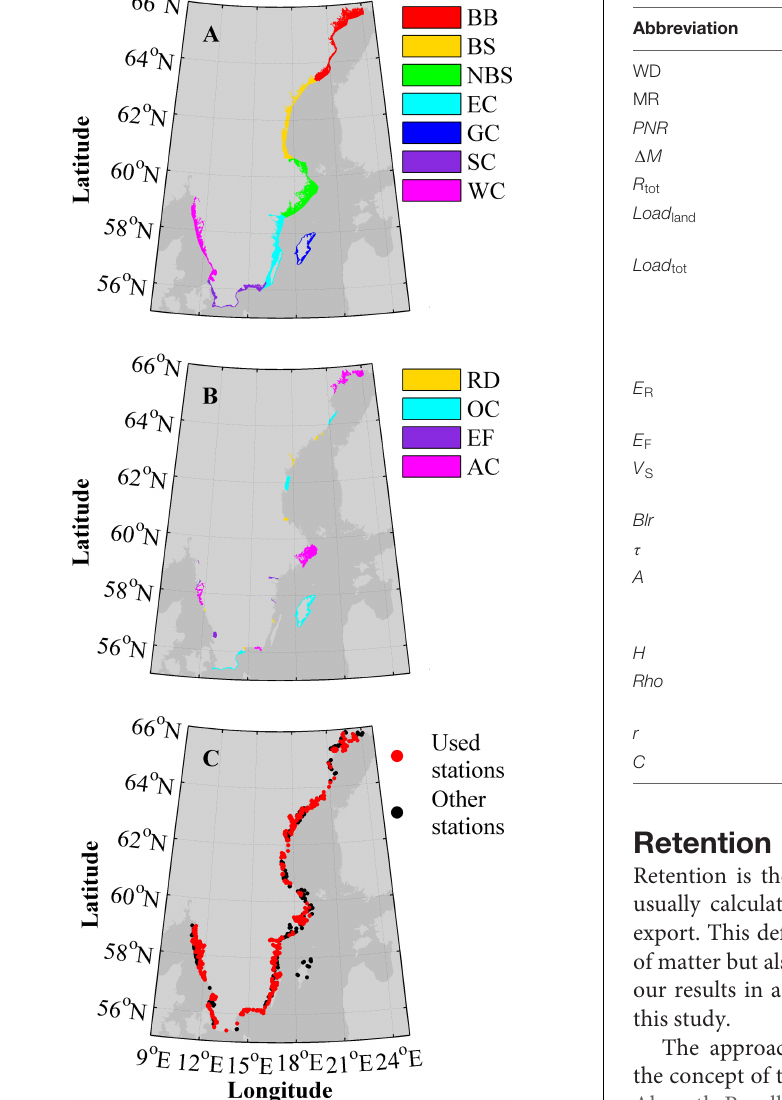
TABLE 1 | List of abbreviations and